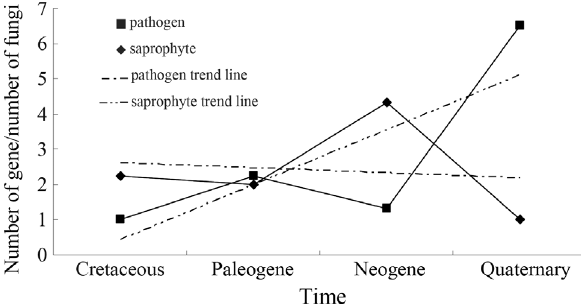
Figure 2 - Distribution of the cerato-platanin-encoding sequences show- ing the evolution of saprophytic and parasitic fungi in relation to their ani- mal, plant, animal and plant, or fungal